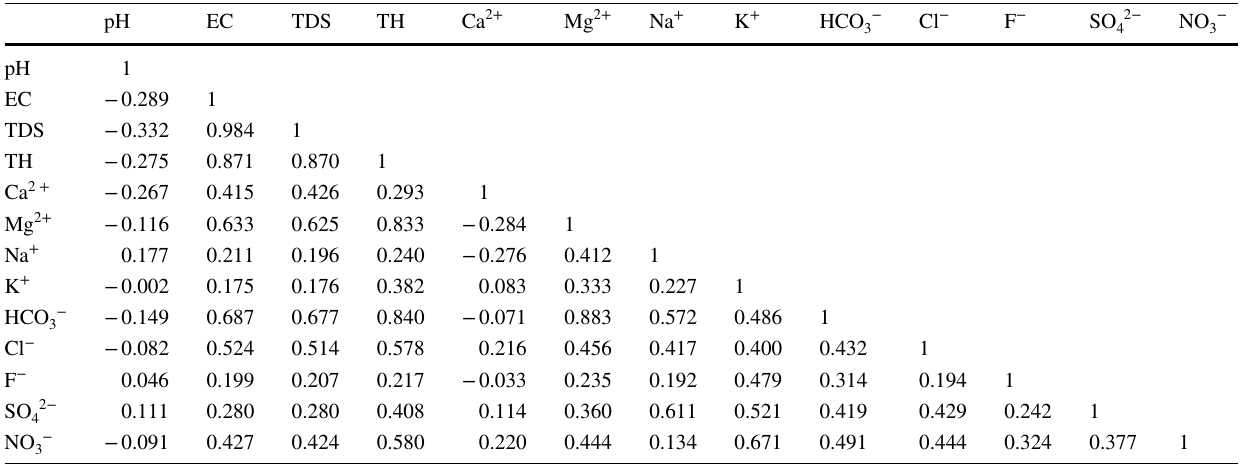
Fig. 2 Spatial distribution of the groundwater quality index (GWQI) Table 6 Pearson’s classification showing the coefficient of groundwater